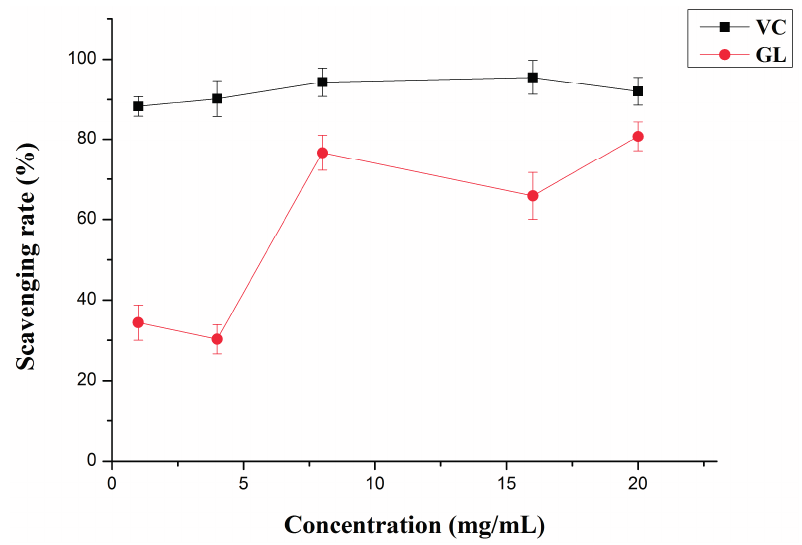
Figure 3. DPPH radical scavenging activity of GL polysaccharides and VC. Data are mean ± SD ( n = 3).